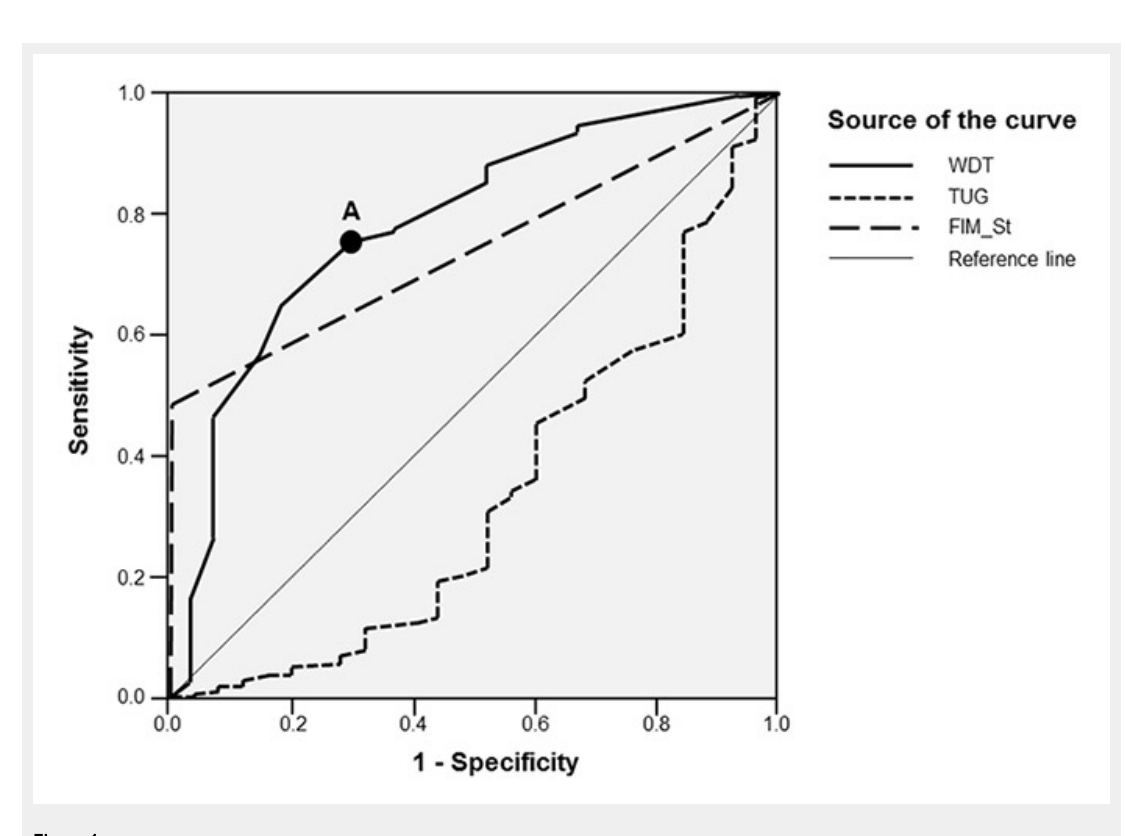
Receiver operating characteristic (ROC) curves for the motor tests at admission. Point “A” depicts the optimal cut-off value of 27 metres for dichotomisation of WDT. FIM_St = functional independence measures score for stair climbing; TUG = timed-get-up-and-go test at admission; WDT = walking distance at